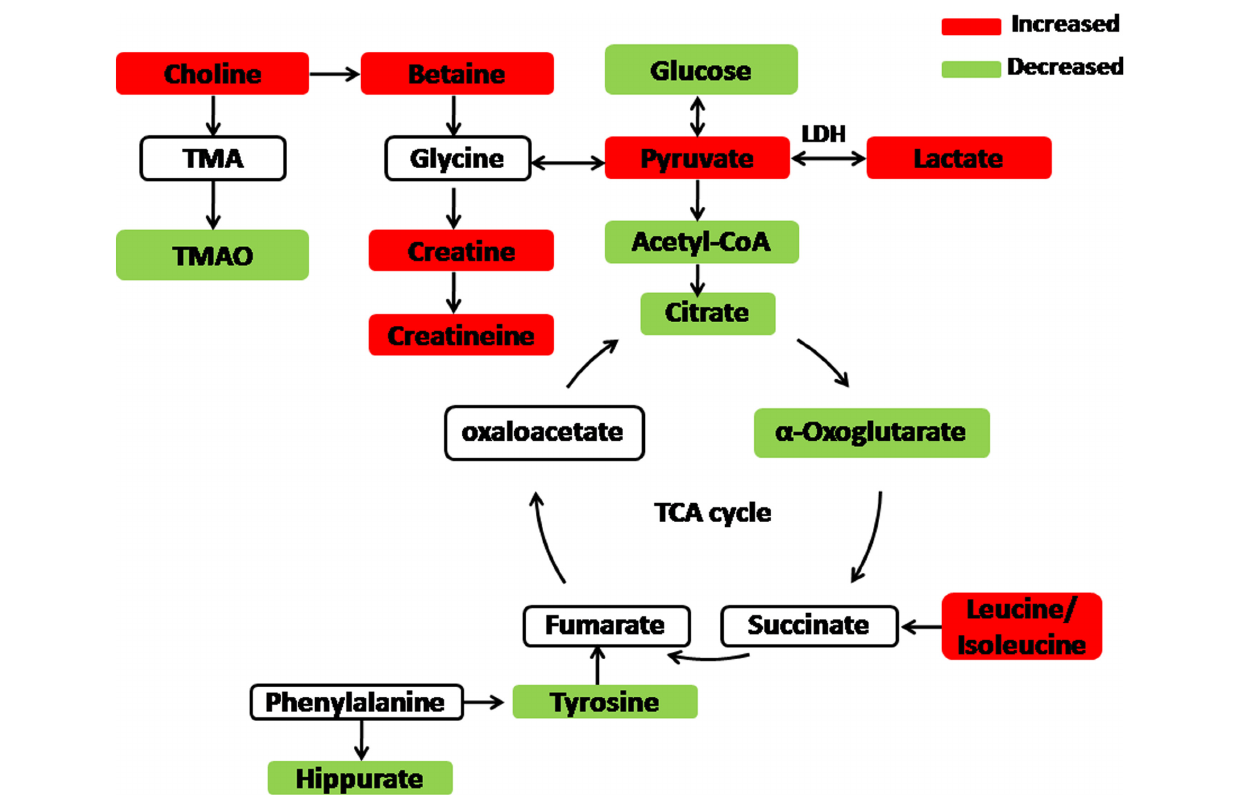
FIGURE 6 | The schematic representation of the metabolic